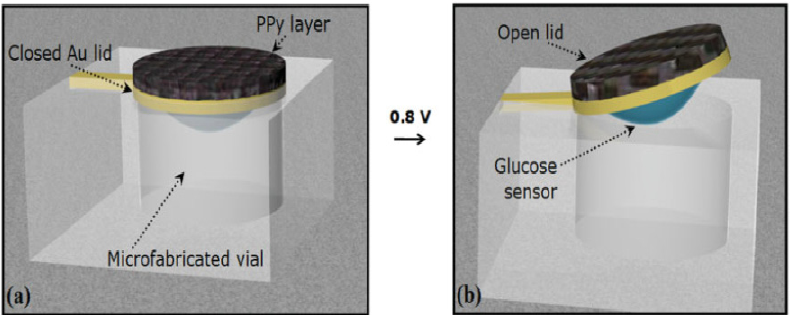
Figure 14. Micro-reservoir and microvalves in microfluidics technology (adapted from